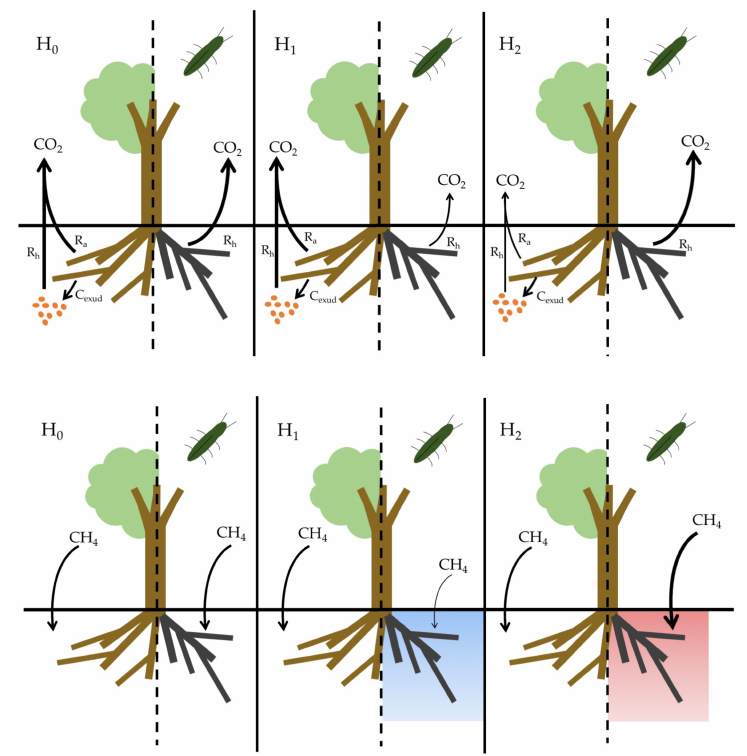
Figure 1. Null hypothesis (H 0 ) and two alternate hypotheses (H 1 and H 2 ) for the effect of tree stress induced by the emerald ash borer (EAB) on soil CO 2 flux and CH 4 uptake. H 0 poses that there is no net change on soil flux, including autotrophic (R a ) and heterotrophic (R h ) respiration, since processes that differ beneath live and dead Fraxinus americana L. might balance each other. Other alternate hypotheses suggest that either live or dead F. americana might have higher soil flux due to biological and physical changes to the soil beneath impacted